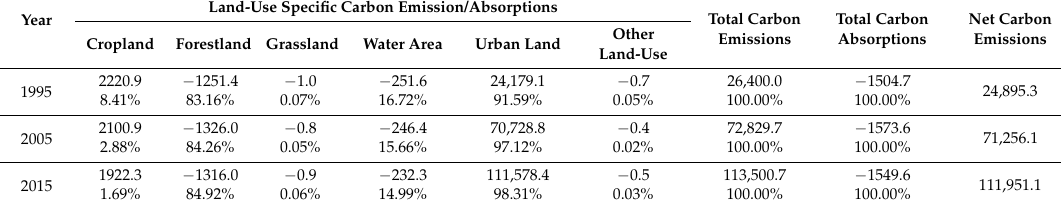
Table 5. The land-use specific carbon emissions and absorptions, the total carbon emissions and absorptions, and the net carbon emissions of the YRDUA for different periods (unit: 10 4 t). Percentages for cropland and urban land refer to their contribution to the net carbon emissions, while percentages for forestland, grassland, water area, and other land-use refer to their contribution to the carbon